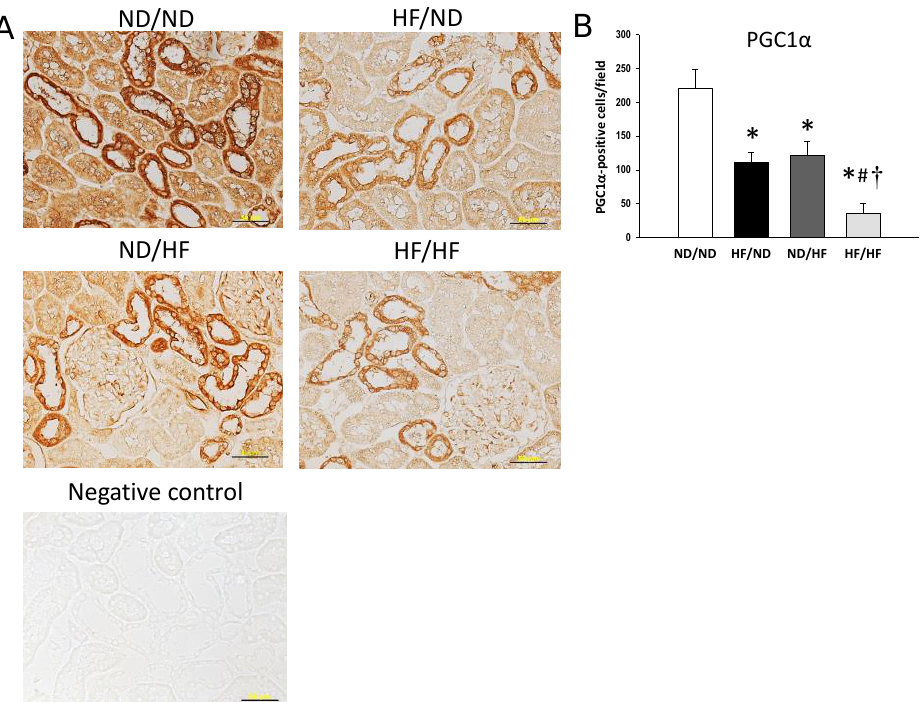
Figure 4. ( A ) Light microscopic findings of PGC-1 α immunostaining in the kidney cortex in 16-week-old male o ff spring. Bar = 50 µ m; ( B ) Quantitative analysis of PGC-1 α -positive cells per microscopic field (400 × ); * p < 0.05 vs. ND / ND; # p < 0.05 vs. HF / ND; † p < 0.05 vs. ND /HF.